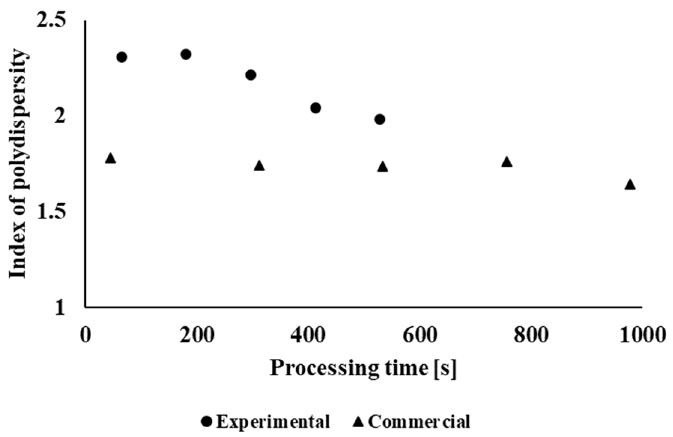
Figure 8. Dependence of the polydispersity index on the total retention time of the material in the processing equipment.